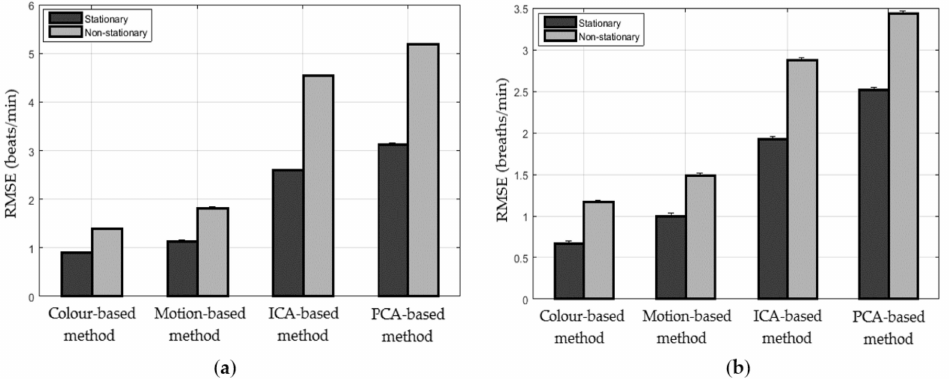
Figure 12. RMSE performance comparison of CEEMDAN and CCA techniques at long range [117]. ( a ) RMSE performance comparison for HR, ( b ) RMSE performance comparison for